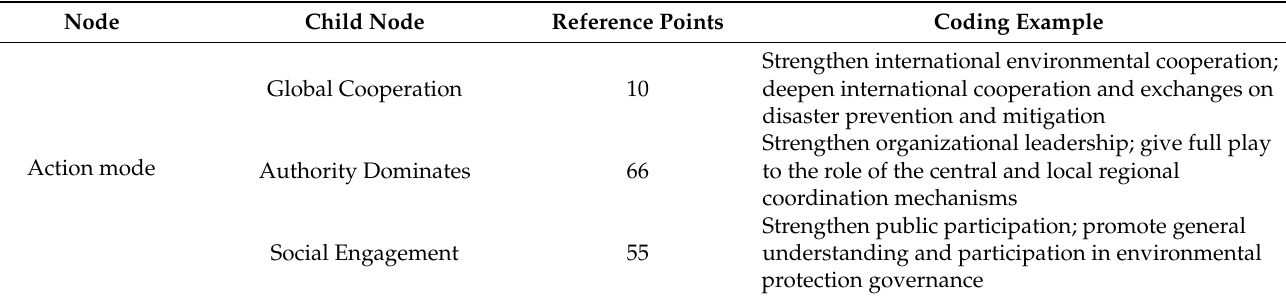
Table 6. “Action Mode” node hierarchy and coding information